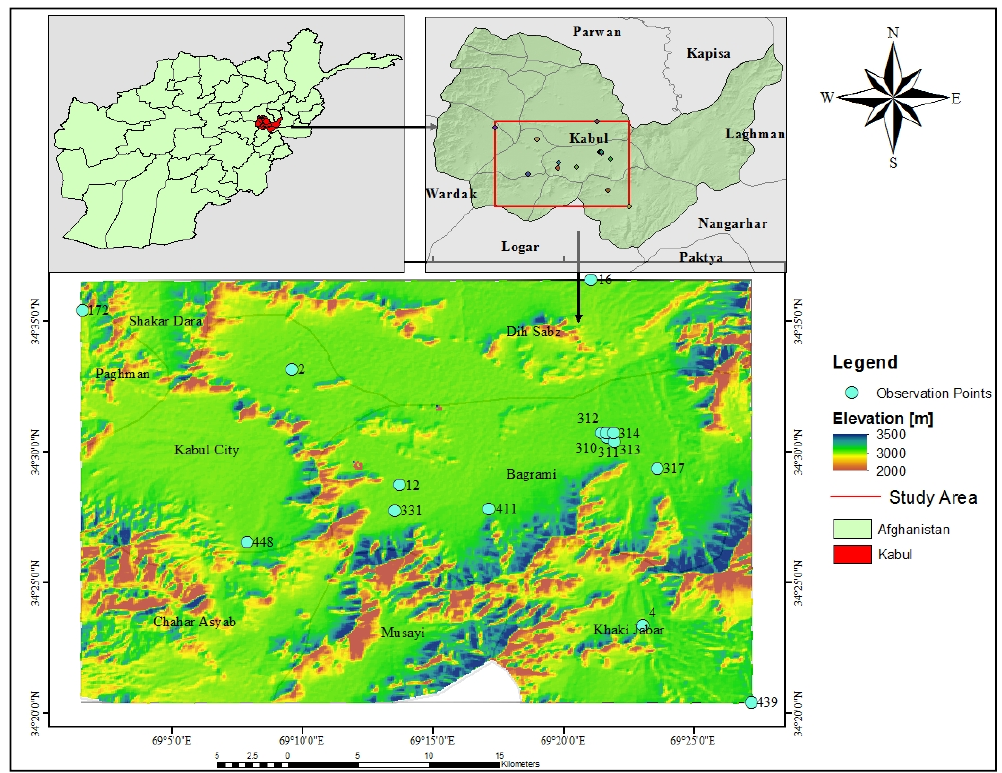
Figure 1. Kabul Basin and the observation points.